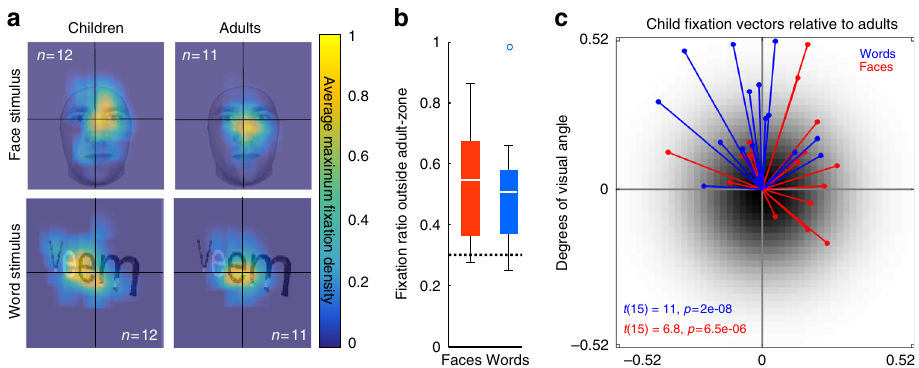
Fig. 5 Biases in fi xation patterns on faces and words mirror pRF development. a Average maximum fi xation density maps produced from 12 children and 11 adults during a free-viewing recognition task are overlaid on an example face (top row) and pseudoword (bottom row) stimulus. Fixation density patterns in adults are more centrally placed on faces and words than in children. b The mean ratio of fi xations in children made outside of an adult-like zone de fi ned as the region where 70% of adults or greater fi xated on the stimulus. The dashed line at 0.3 denotes the expected adult value. White: median; box: 25th and 75th percentiles; whiskers: range; circles: outliers; C: children; A: adults; red: unfamiliar faces; blue: pseudowords. c Vectors describing the bias in child fi xation densities for all face (red) and pseudoword (blue) stimuli relative to the center of adult fi xation densities for each stimulus. Each vector is the bias for a particular stimulus. Black Gaussian center represents the centrally-biased adult fi xation densities. t -tests evaluate if the angular distance of vectors from the null quadrant are signi fi cantly different from zero. The null quadrant is de fi ned as the lower left quadrant for faces and lower right for words (see